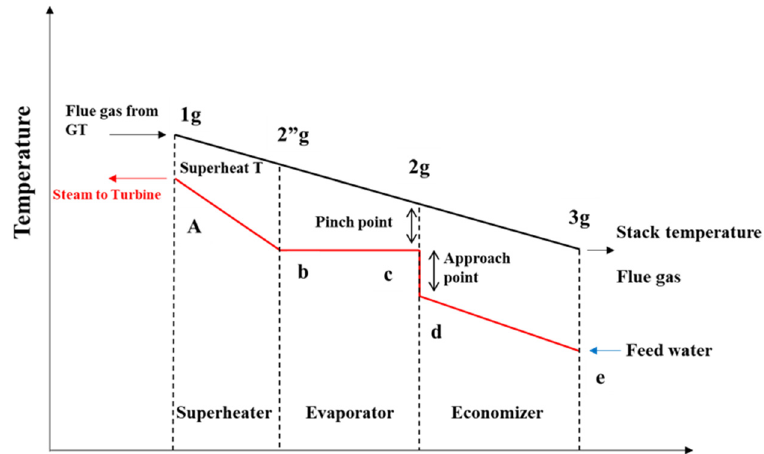
Figure 3. Temperature diagram of the heat recovery steam generator (HRSG); A: outlet steam mass flow temperature from HRSG to steam turbine; b and c: temperature of the steam inlet and outlet the evaporator; d: outlet fluid mass flow temperature from